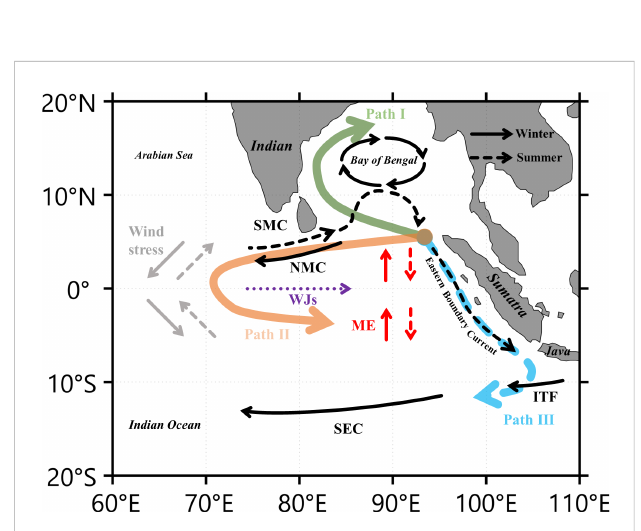
FIGURE 12 Three typical pathways as described in section 3.2 and the seasonal currents of the EIO. The solid and dashed arrows represent winter and summer, respectively. The red (ME) and gray arrows indicate the directions of meridional Ekman currents and wind stress, respectively. The green, orange, and blue arrows represent path I, path II, and path III, respectively. The purple-dotted arrow indicates the WJs which appear in the monsoon transition seasons. The black arrows south of 10°S are the SEC and ITF which appear throughout the